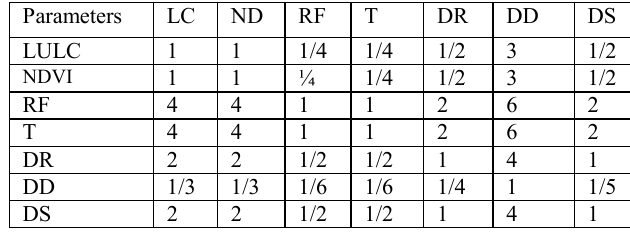
Table 5 Matrix showing the couple comparison of the factors for fire vulnerability